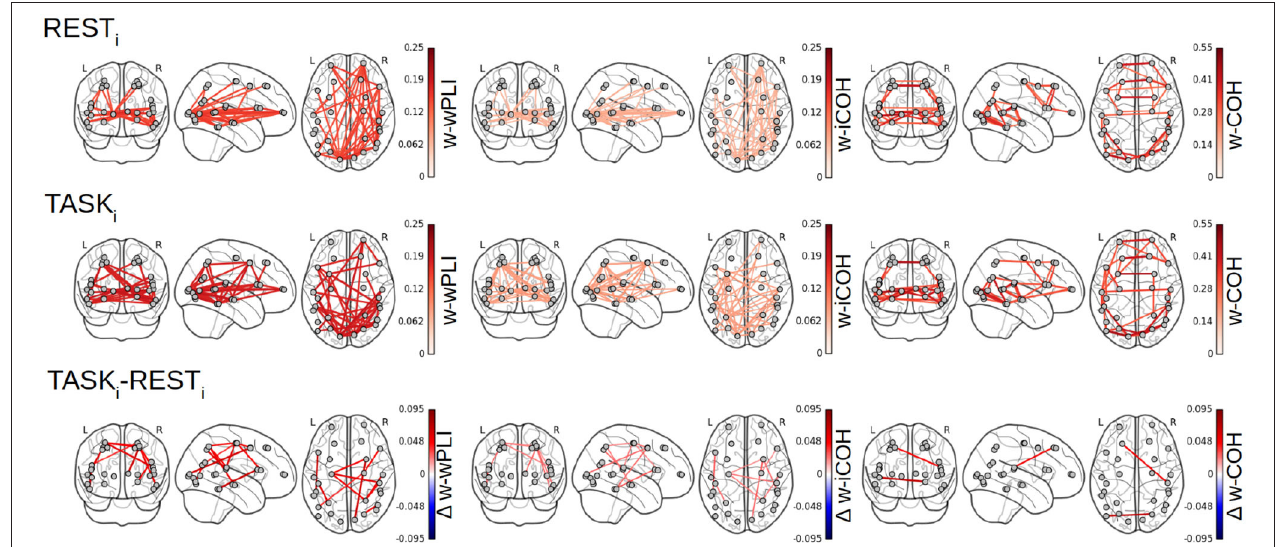
FIGURE 7 | Functional connectivity assessment from fractal dynamics: Group-level functional connectivity in infraslow MEG-source reconstructed brain dynamics. Filtered 28 × 28 connectivity networks measured from Complex Wavelet based W-wPLI (left), W-ICOH (middle), and W-COH (right), for REST i (top row) and pre-training TASK i (center row). The red color intensity codes for the values of the connectivity indices (ranging from 0 to 1 by construction). Functional connectivity differences between conditions TASK i and REST i when assessed as significant by a group level FDR corrected t -test are displayed in the bottom row. Color codes for the TASK i − REST i differences in the values of indices from blue (negative) to red (positive), thus indicating that only increases in functional connectivity are observed from REST i to TASK i